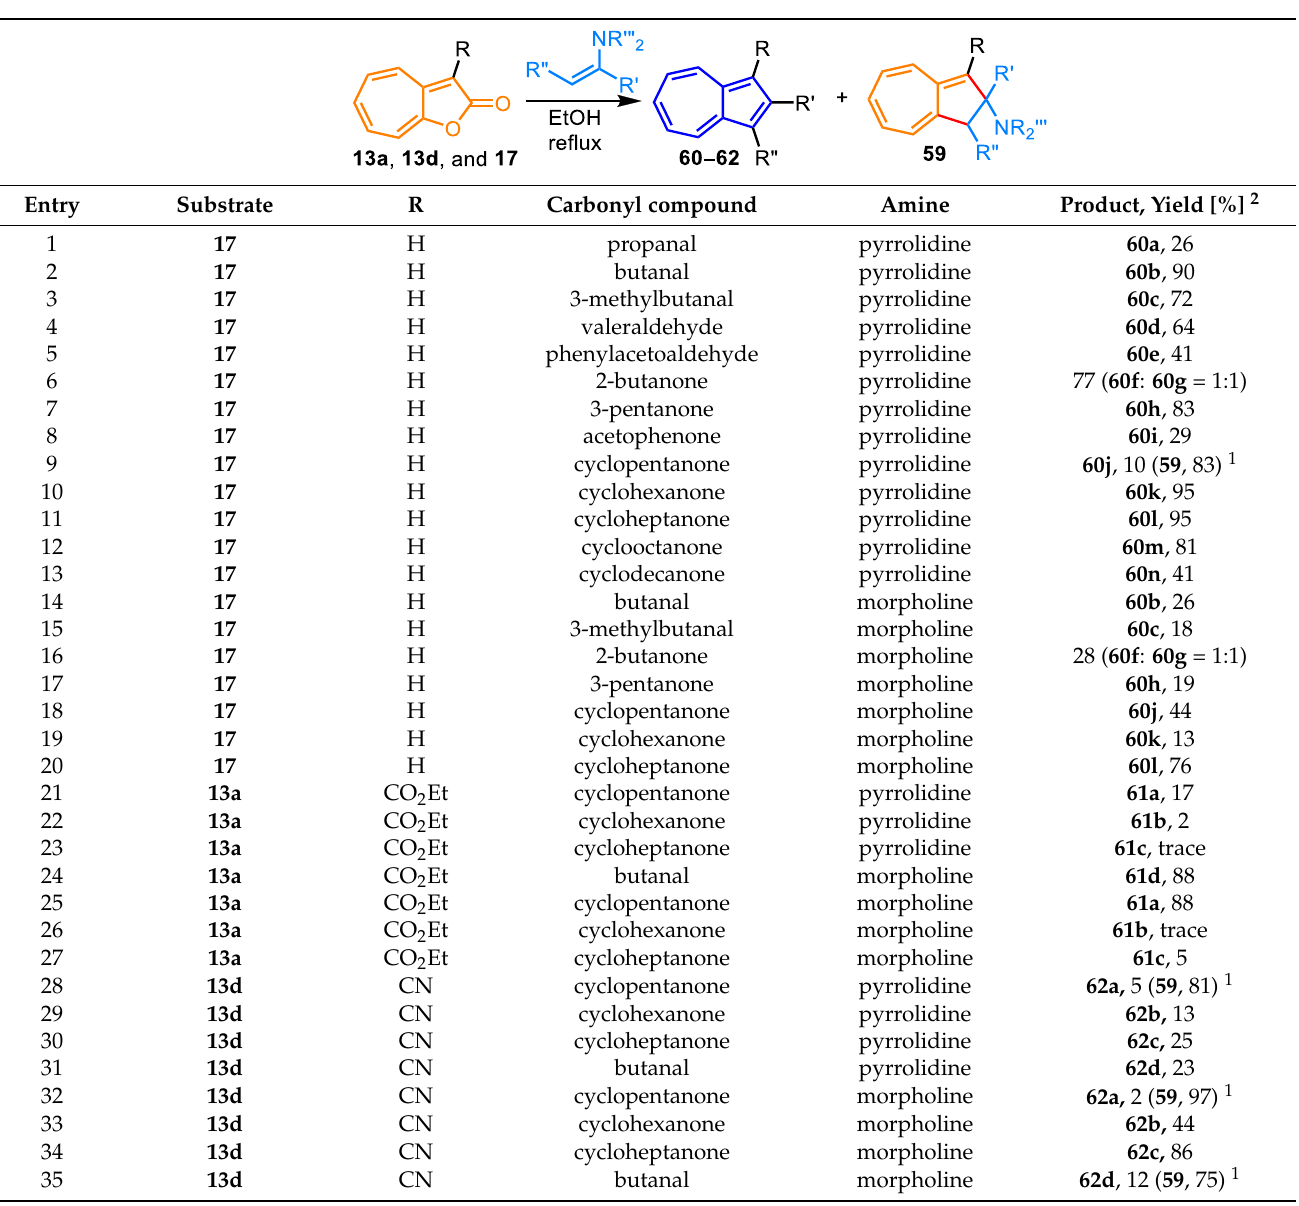
Table 3. Synthesis of azulene derivatives 55 – 57 by the [8 + 2] cycloaddition of 2 H -cyclohepta[ b ]furan-2-ones with various enamines.